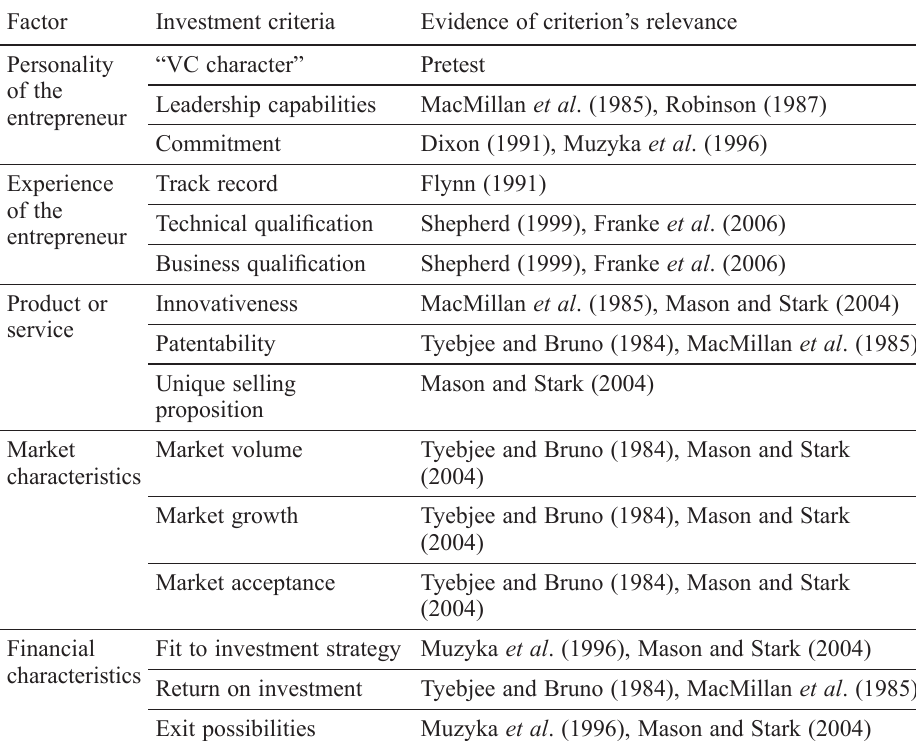
Table 1. Venture capitalists’ investment criteria (Kollmann, Kuckertz 2010) Factor Investment